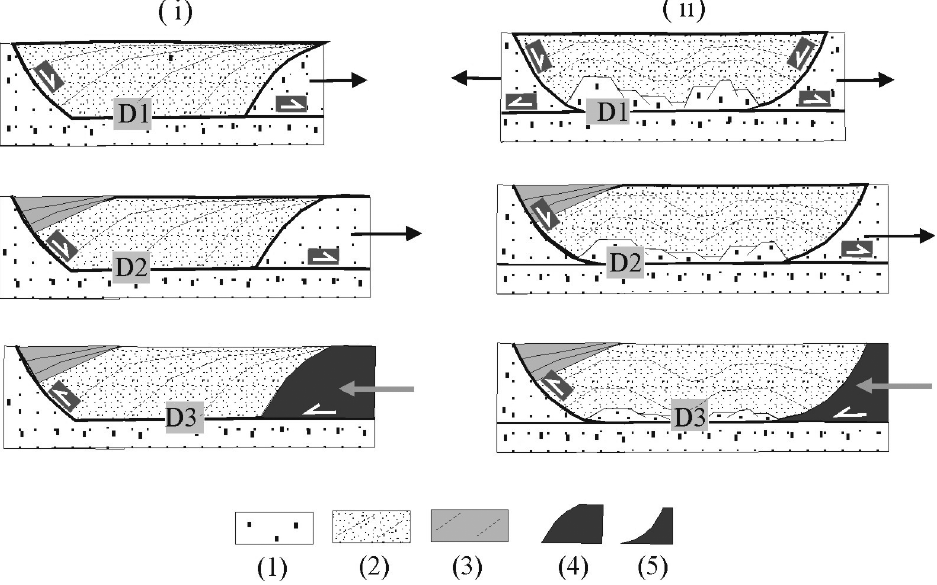
Fig. 1 – Conceptual cartoon showing the authors idea for the positive inversion of a half graben (i) and a graben (ii) by sliding a mobile block above listric or horizontal basal detachments, respectively. Arrows indicate the sense of displacement of the moving walls, and D1, D2 and D3 the active detachments along time. (1) basement; (2) syn-rift 1; (3) syn-rift 2; (4) convex-up backstop, and (5) concave-up backstop during